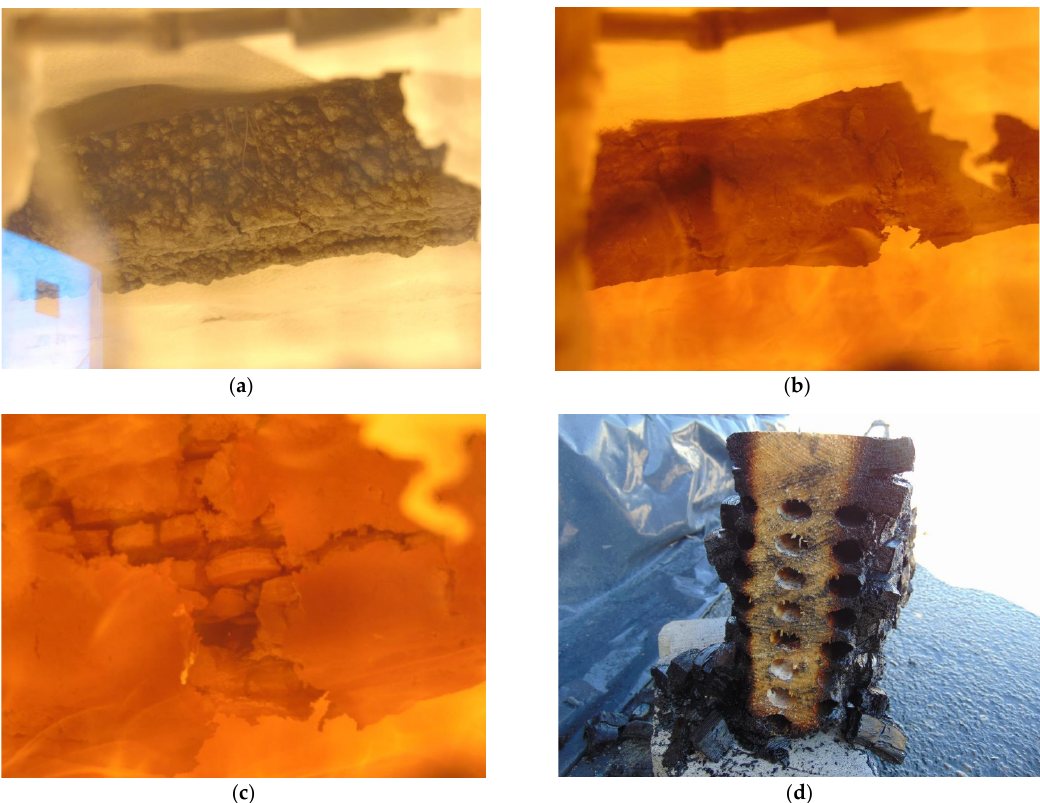
Figure 17. Hollow beam (Promadur)—phases of the fire test: ( a ) 5 min; ( b ) 20 min; ( c ) 41 min; ( d ) the end of the test.